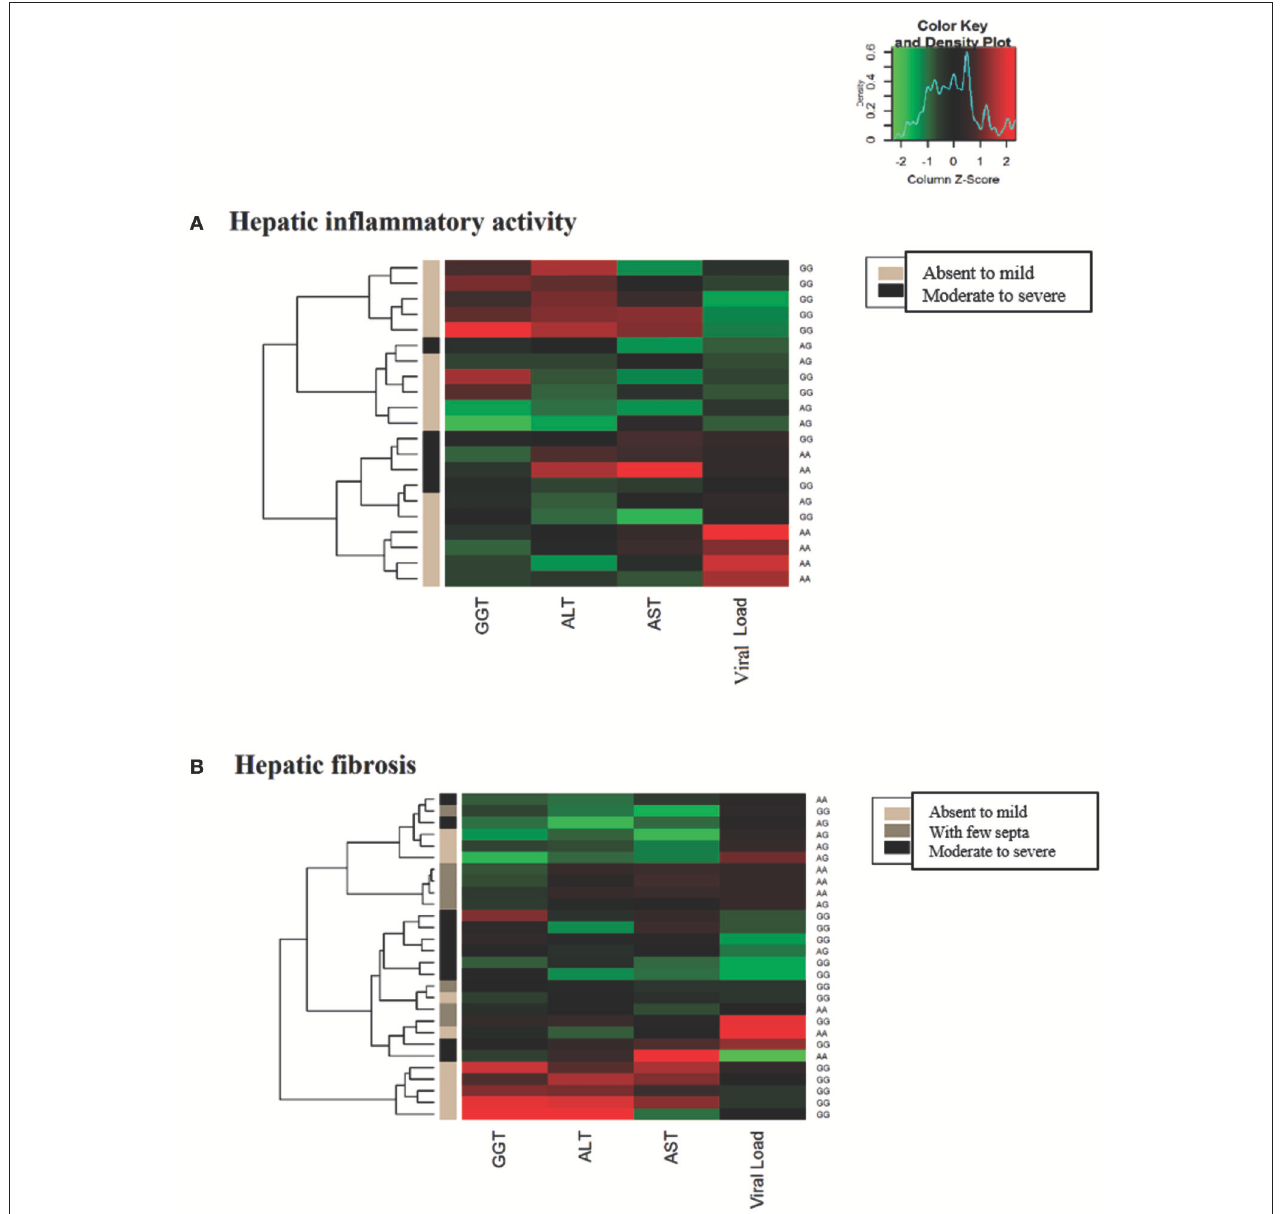
FIGURE 7 | Heatmap matrix constructed to analyze the liver function profiles according to the histopathological characteristics and − 924A > G polymorphism genotypes in CHB-A patients. (A) Regarding inflammatory activity, high hepatic enzyme levels were clustered with low viral loads for patients with the GG genotype with mild to absent inflammatory activity. Another cluster was formed among patients with low hepatic enzyme levels and high viral loads in AA genotype individuals with low tissue inflammation. (B) Regarding liver fibrosis, elevated liver enzyme levels were clustered with intermediate viral loads for GG genotype patients with mild to absent